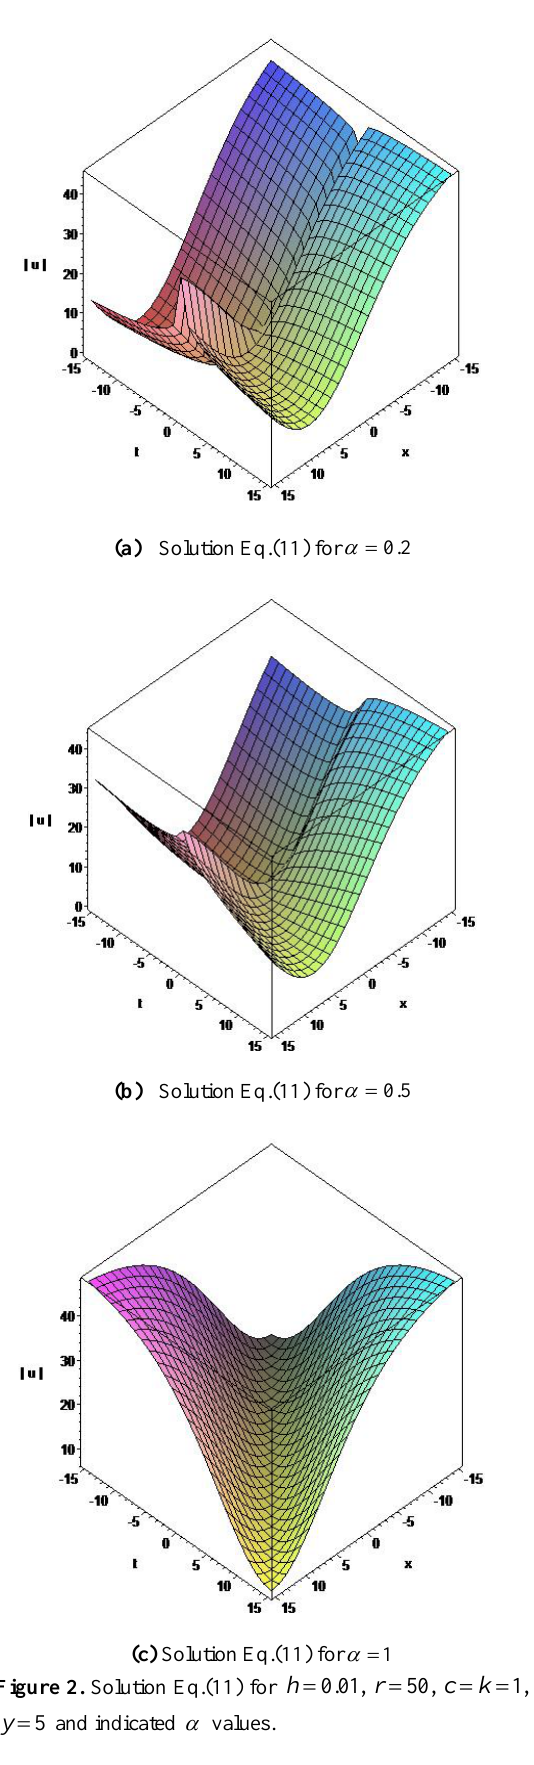
Figure 1. Solution Eq.(11) for 0.01, 50, h r = = 1, c k = = 10 t = and indicated  values.